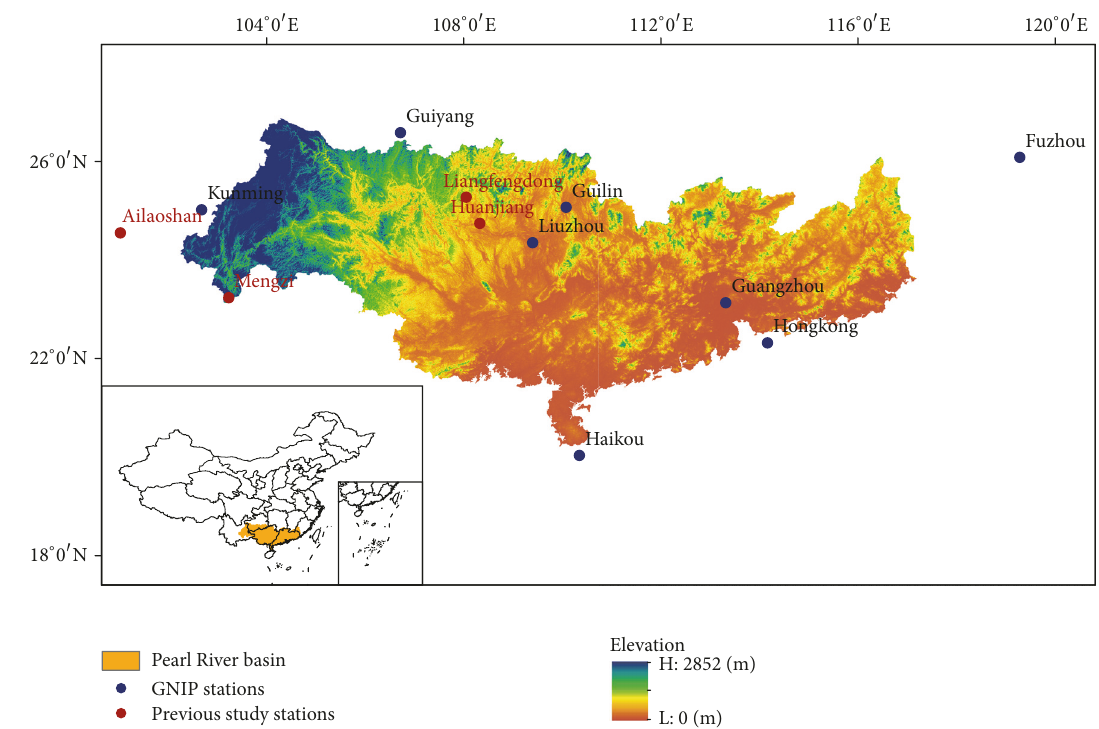
Figure 1: Location of the GNIP and previous studies stations in the PRB and adjacent regions.